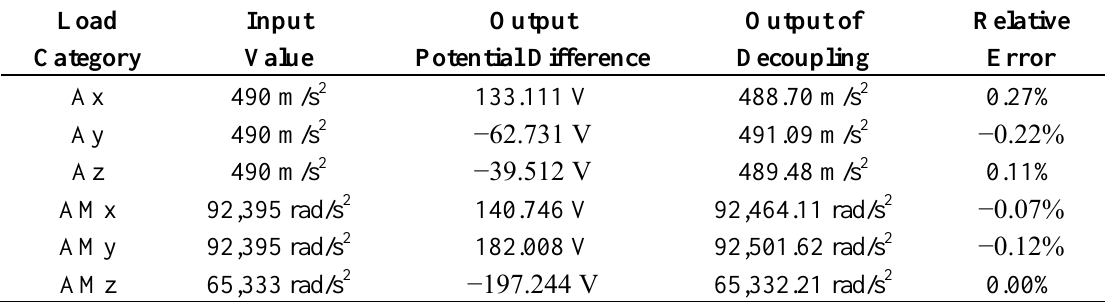
Table 5. Analytical results of composite